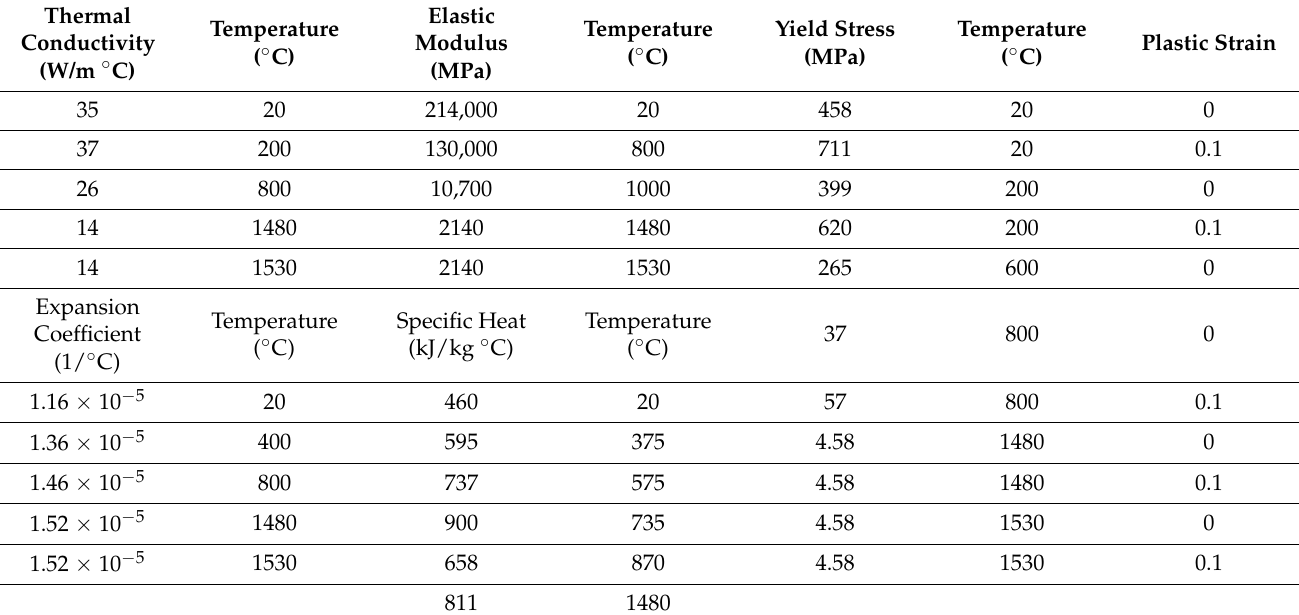
Table 3. Thermal and mechanical properties of the parent